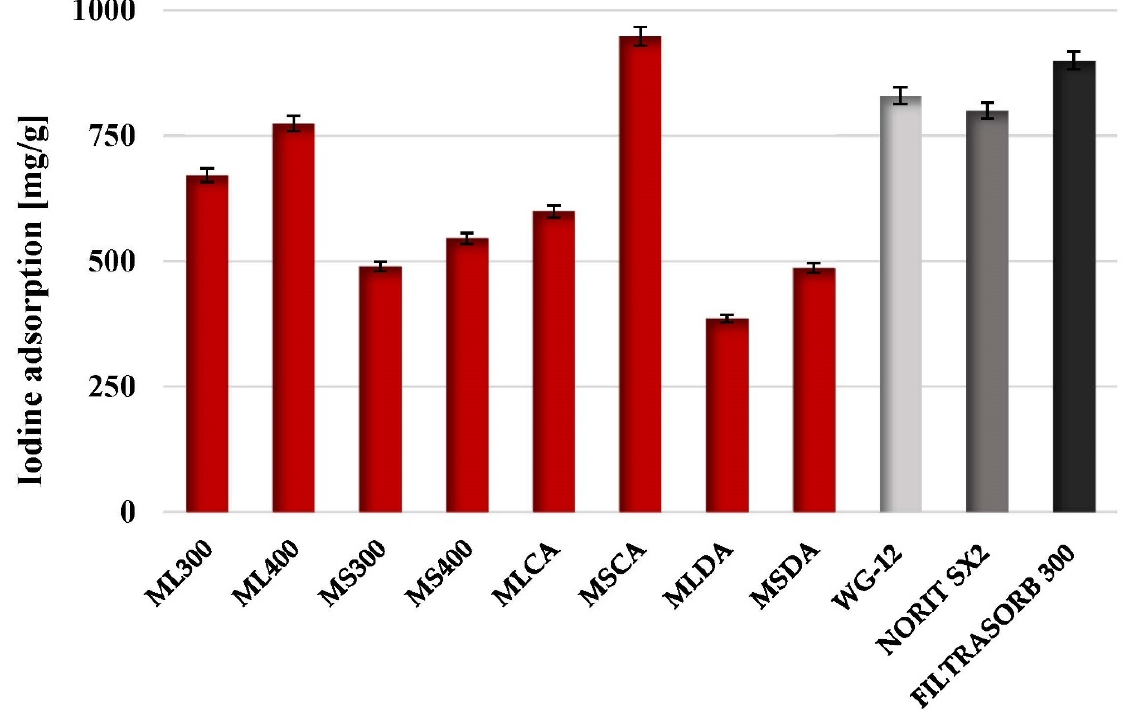
Figure 4. Comparison of iodine adsorption by biochars and activated biocarbons prepared from mugwort post-extraction residue with commercial products.